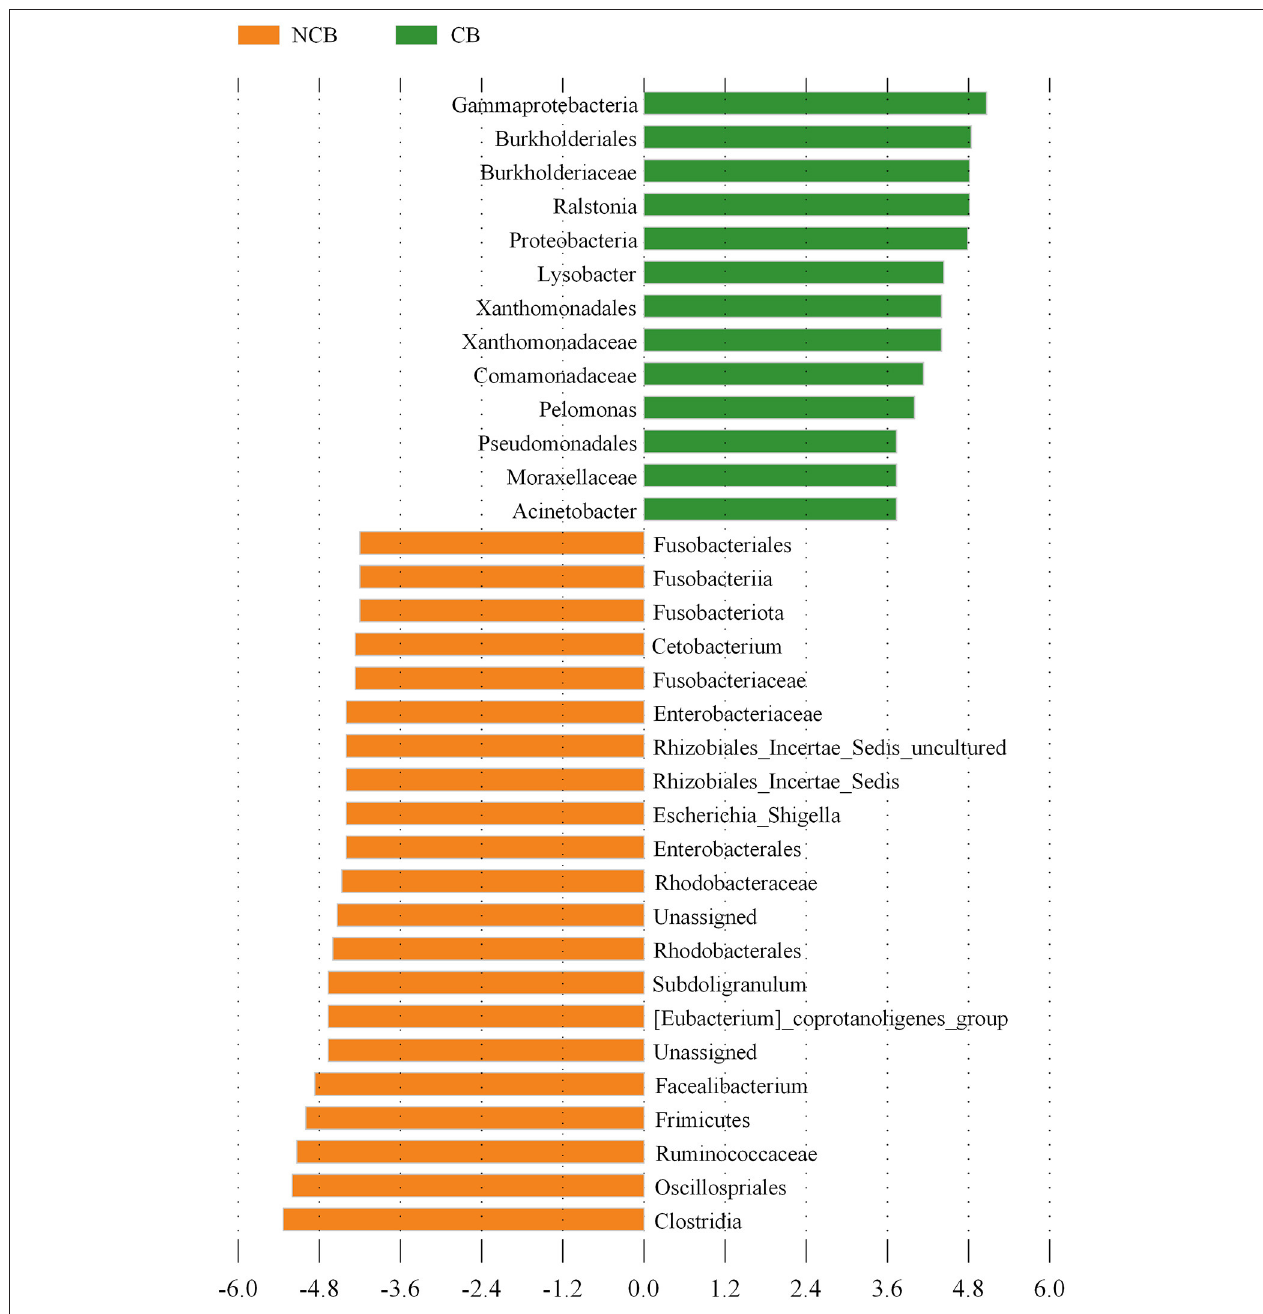
FIGURE 4 | Bacterial taxa differentially represented between the non-cyanobacterial bloom (NCB) period and the cyanobacterial bloom (CB) period, as determined by LEfSe by using the default parameters.